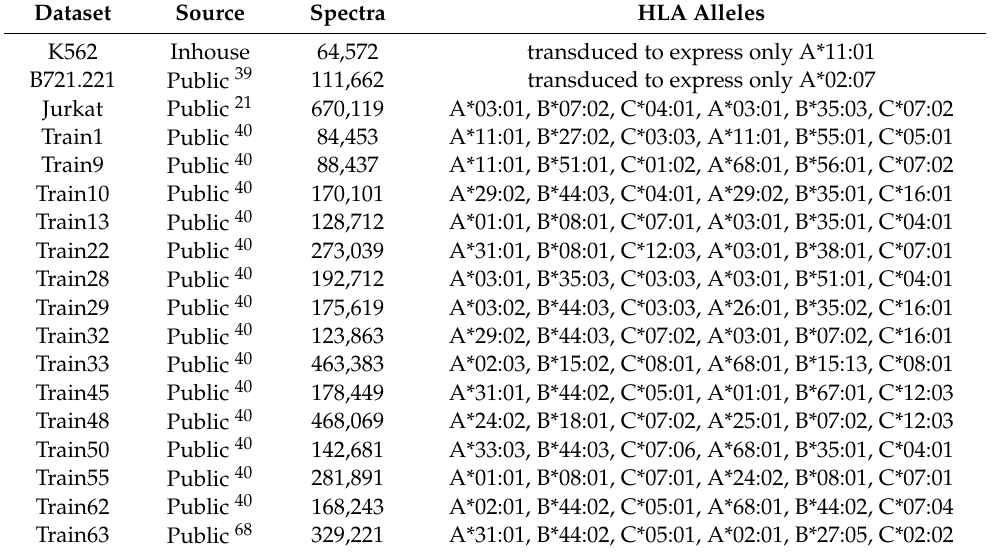
Table 1. Summary of immunopeptidome data